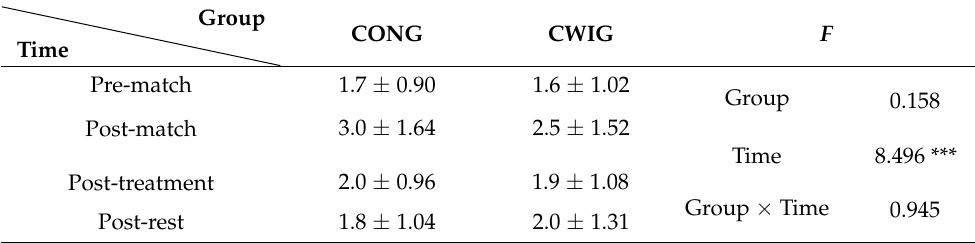
Figure 3. Change in MDA concentration after CWI. (Data are expressed as mean ± standard deviation. A main effect was evident by time p < 0.001. CWI: cold-water immersion). Table 3. Change in SOD concentration after CWI (unit/mL).